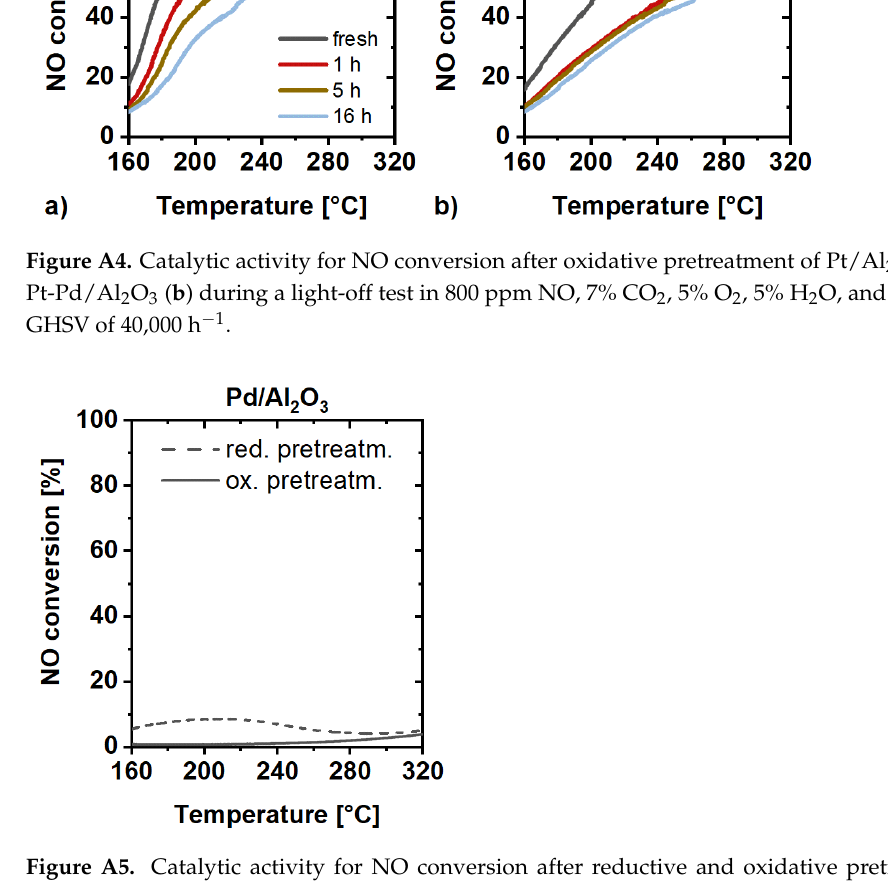
Figure A6. Turnover frequency (TOF) for CO oxidation at 120 °C of Pt/Al 2 O 3 , Pd/Al 2 O 3 and Pt- Pd/Al 2 O 3 during a light-off test (after reductive pretreatment) in 800 ppm CO, 7% CO 2 , 5% O 2 , 5% H 2 O, and bal. N 2 at a GHSV of 80 000 h − 1 . References 1.